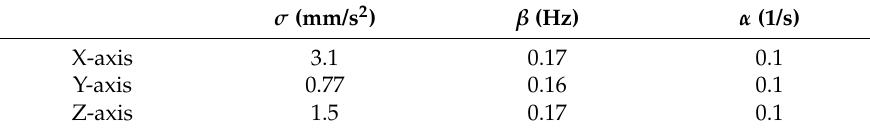
Table 3. Model parameters of dynamic lever-arm acceleration.